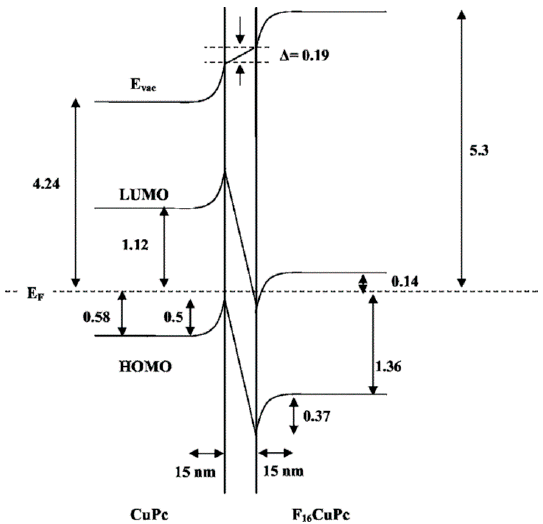
Figure 5. Representation of band bending of HOMO and LUMO levels in Cu(F 16 Pc)/CuPc heterostructure associated with overlapping of HOMO of CuPc and LUMO of Cu(F 16 Pc)